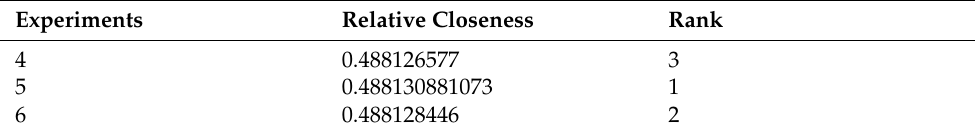
Table 15. Relative closeness.